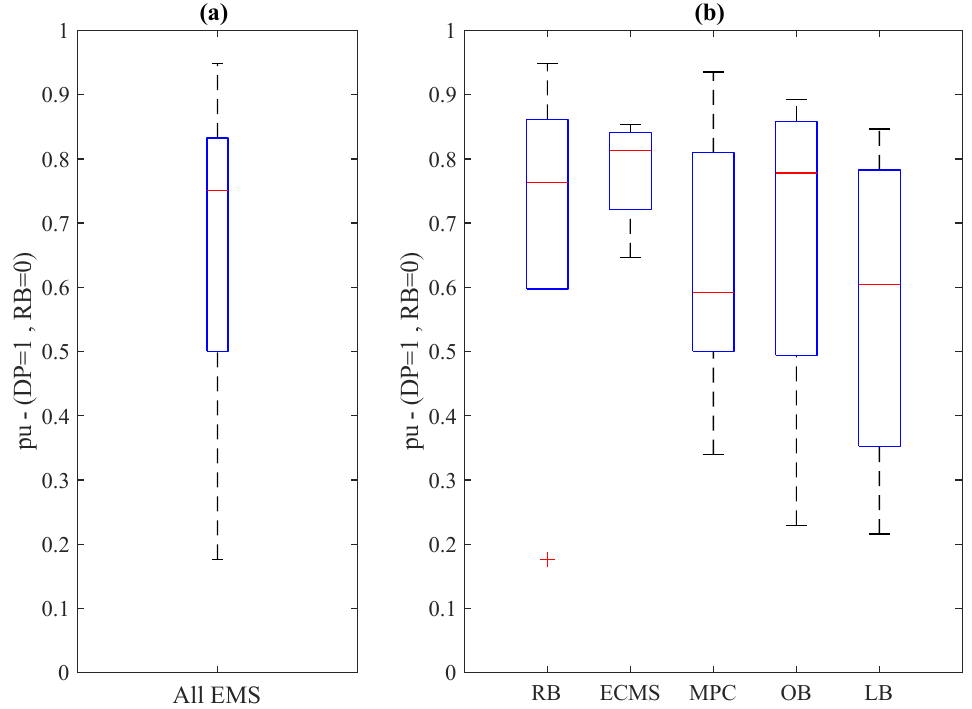
Figure 7. Normalized fuel consumption results for the EMSs of the works reviewed. ( a ) Boxplot for all the EMSs; ( b ) boxplot for the different categories of EMSs.